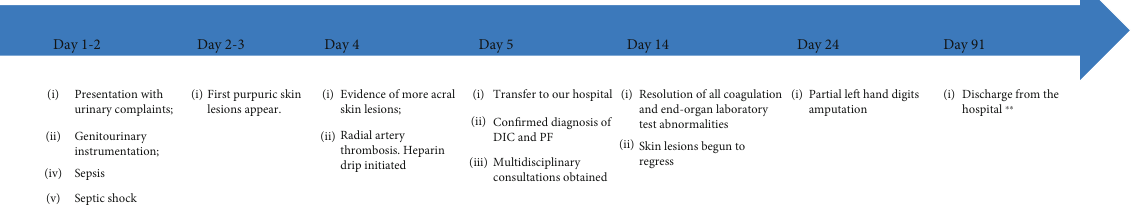
Figure 2: Timeline of the events summarizing the most important moments in the development and management of this patient. ∗∗ Prolonged discharge secondary to disposition issues.